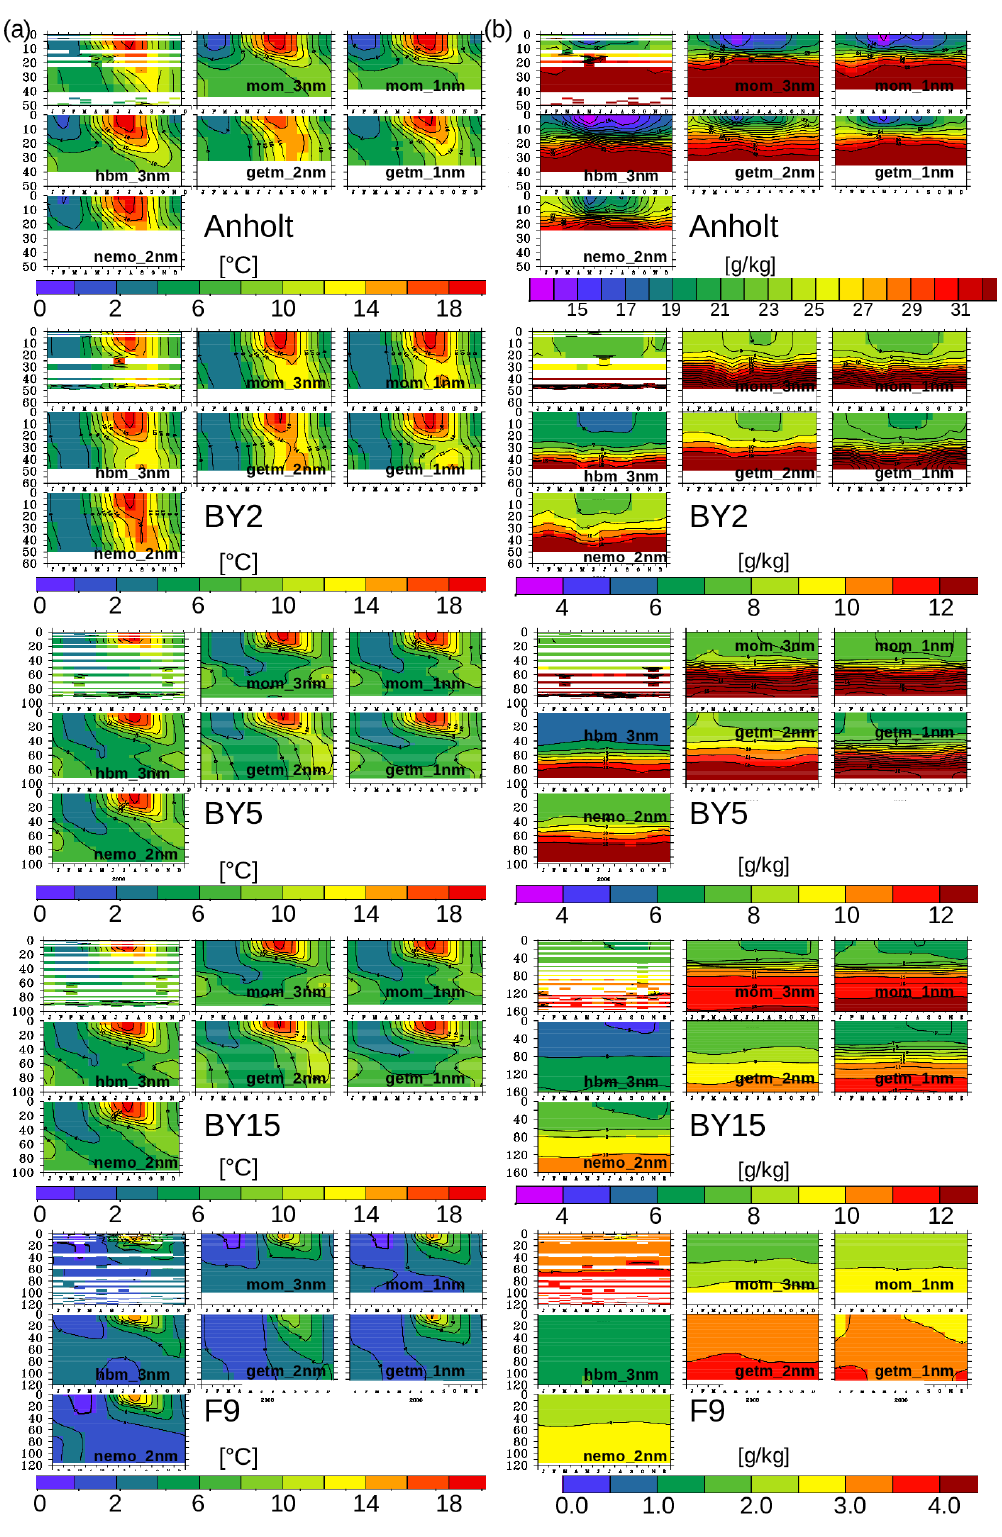
Figure 6. Multiyear (1990–2009) mean seasonal cycle of water column temperature (a) and salinity (b) at selected monitoring sites in the Baltic Sea. See the text for further explanation. The upper-left plot of each panel displays the seasonal cycle based on the SHARK data set. Note the different color scales for salinity at the Anholt and F9